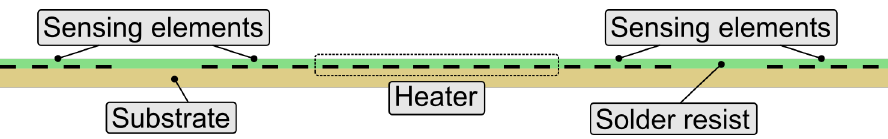
Figure 2. FEM model cross-section. Heating and sensing elements (copper) are placed on top of a substrate (FR4 glass epoxy), passivated by a solder resist (polymide).